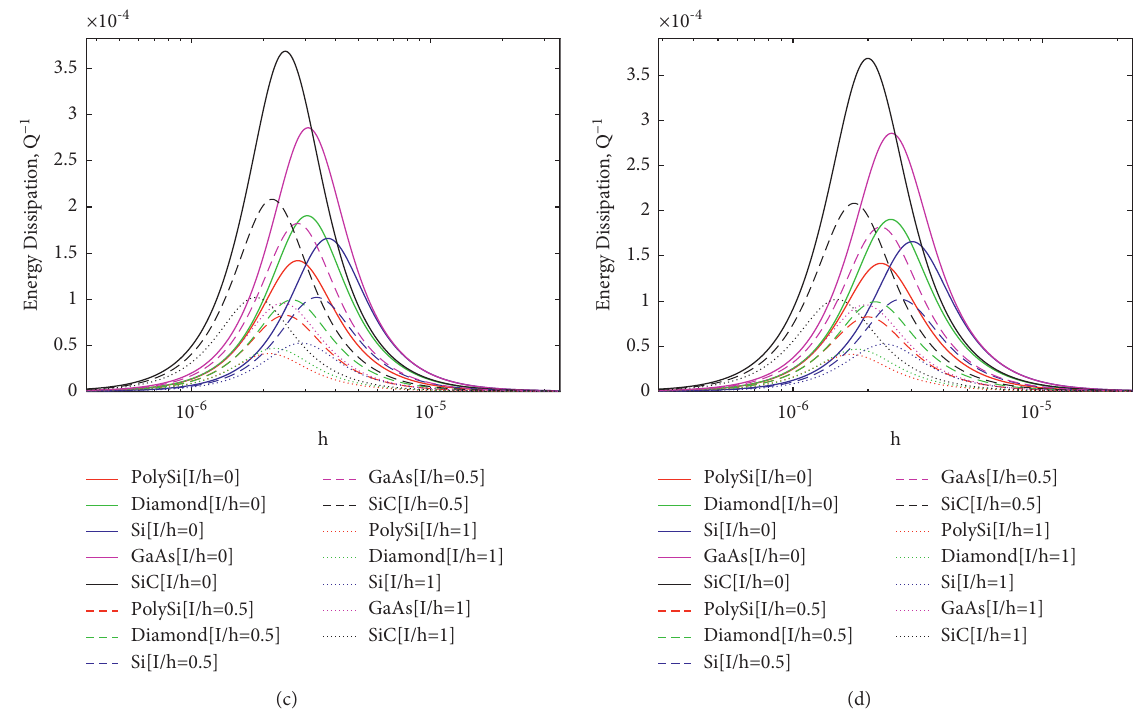
Figure 2: Energy dissipation, Q − 1 vs. thickness, h of a rectangular plate with different modes and boundary conditions: (a) mode (I) simply supported (SS); (b) mode II, simply supported (SS); (c) mode (I) clamped-clamped (CC), and (d) mode II, clamped-clamped (CC).